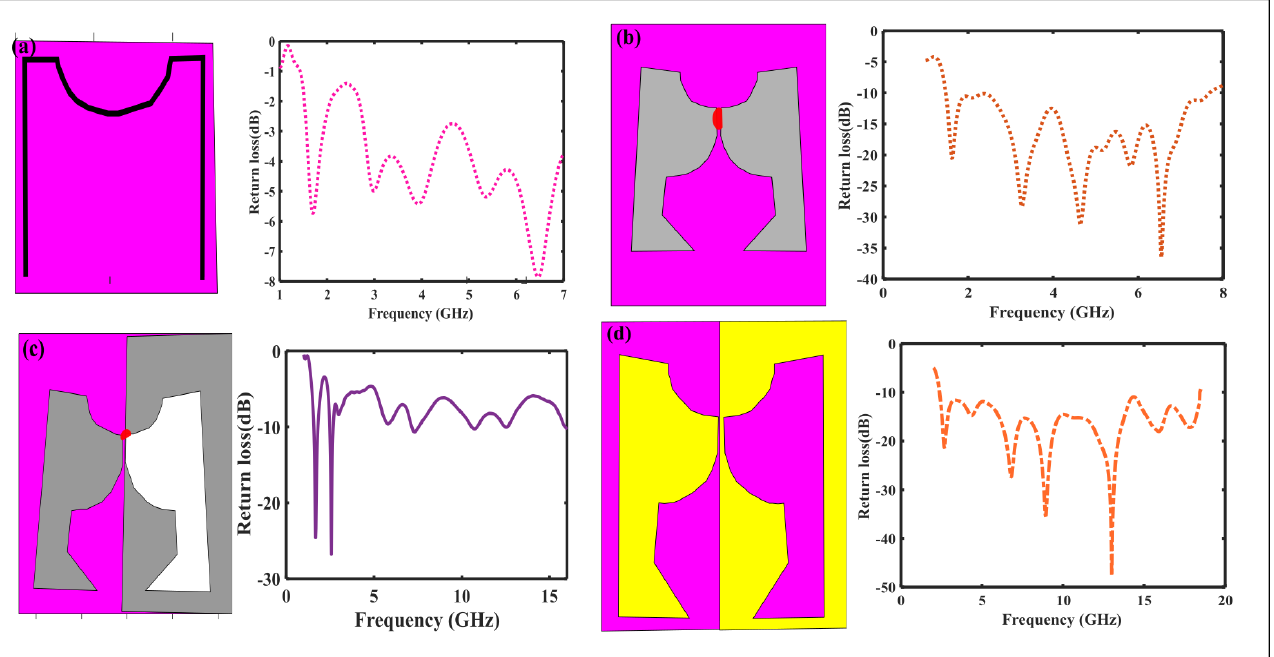
Figure 3. Steps for Proposed Antenna Design ( a ) arc shape dipole antenna ( b ) a boomerang-shaped UWB antenna ( c ) By applying Self-complementary technique ( d ) optimized self-complementary shaped of